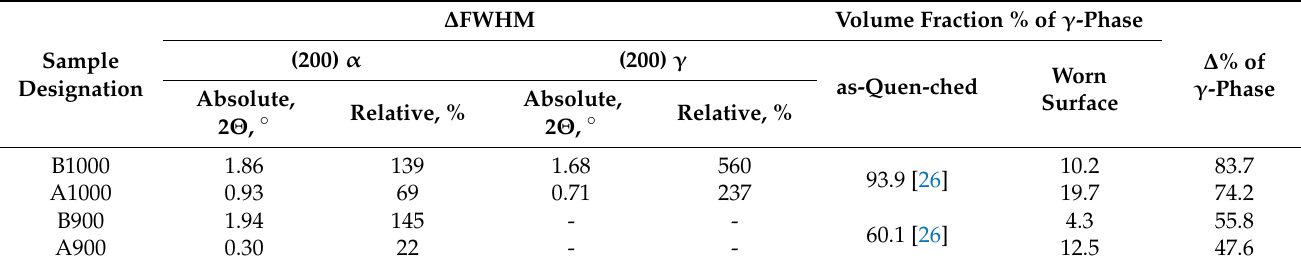
Table 3. Changing FWHM and content of γ -phase in worn samples relative to as-quenched